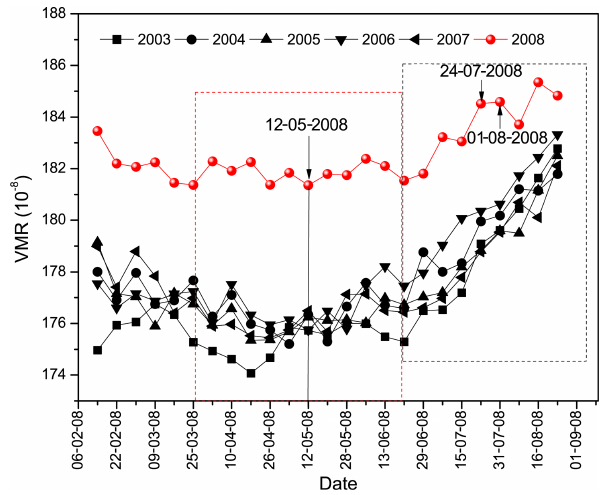
Figure 11. Comparison of the average CH 4 VMR in the study area from 2003 to 2008 (300hPa). Table 1. Linear fitting between 21 June and 1 September for differ- ent